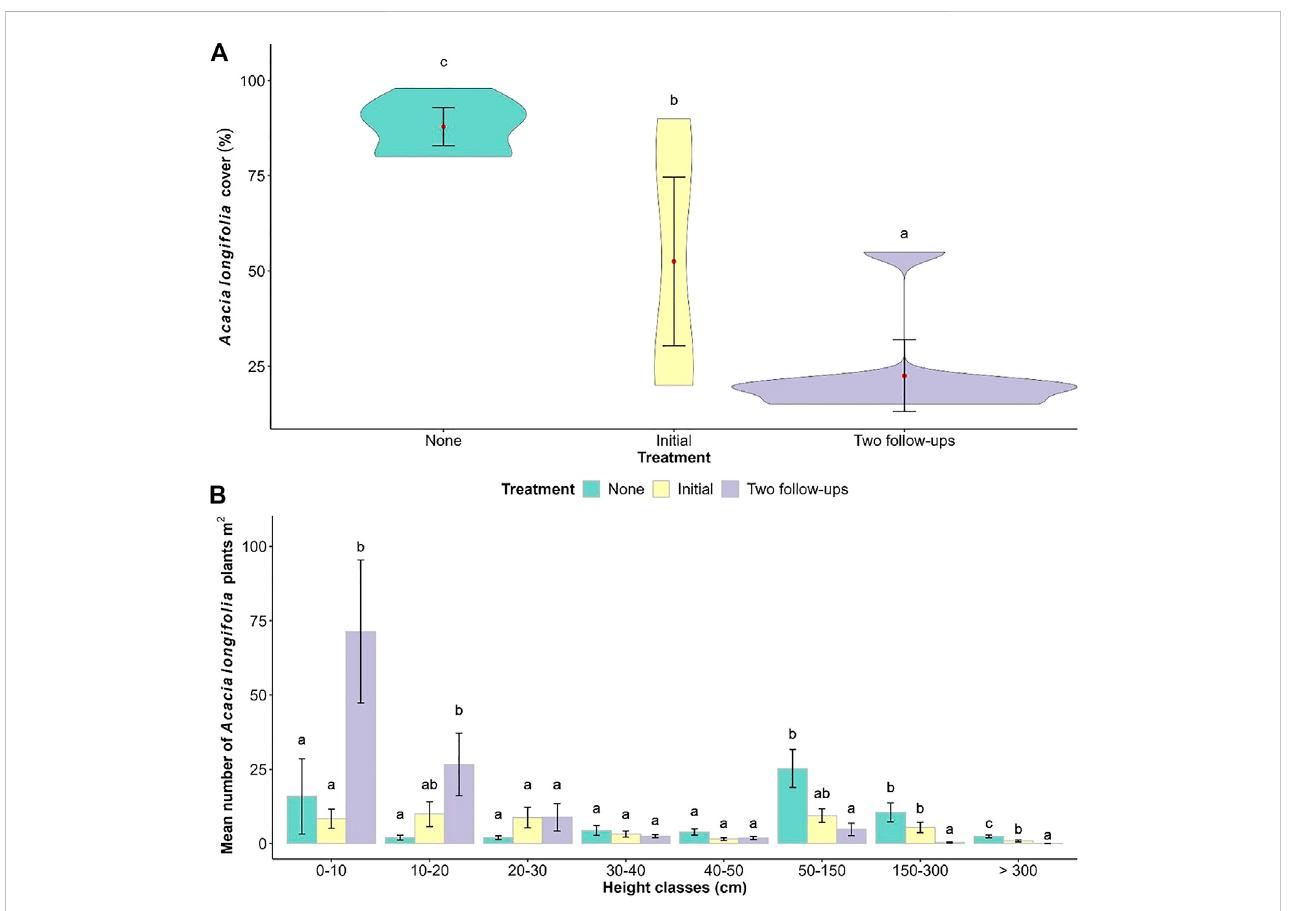
FIGURE 6 Effect ofthenumberof control treatments (0 = none;1 =initial treatment,and 3=initial +two follow-ups) on Vagos dunes. (A) Violinplotdistributionof A. longifolia cover; the red point indicates the mean and the vertical lines (whiskers) represent the standard error. (B) Mean number of A. longifolia plants per m 2 ± SE ( n = 8). Letters show results of Tukey post-hoc